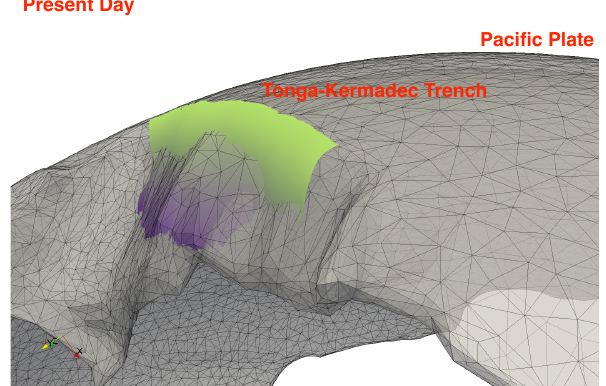
Figure A5. Side view of the Pacific plate at present day for geody- namic model input, looking from the south at the Tonga-Kermadec subduction zone. The green to purple coloured topology represents the depth of the Kermadec slab from the Slab1.0 (Hayes et al., 2012) interpretation. The black mesh over the plate indicates the resolution of the model. The modelled plate is made slightly transparent to see the extent of the Slab1.0 interpretation.